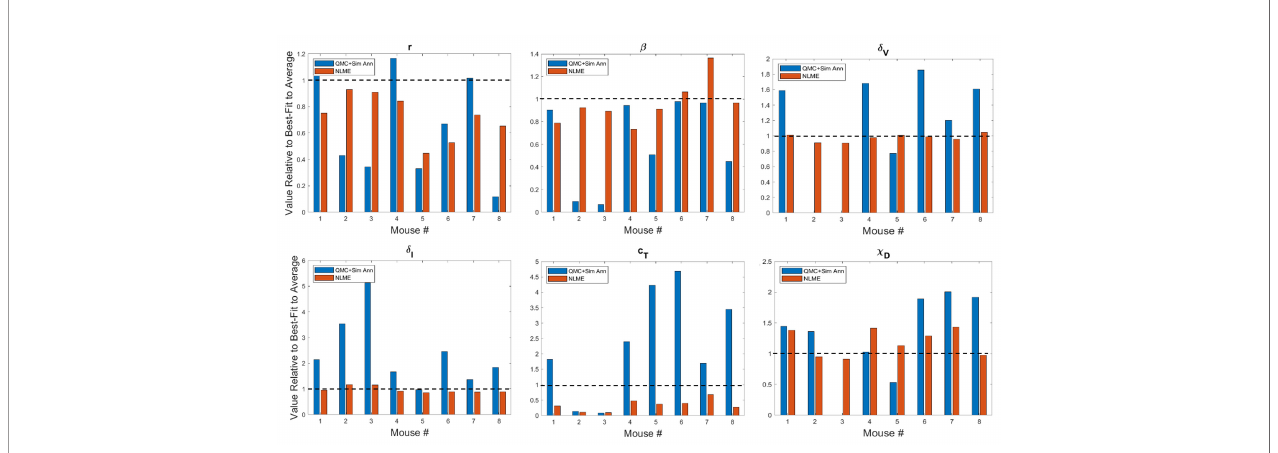
FIGURE 3 | Best- fi t values of tumor growth rate parameter r , virus infectivity parameter b , viral decay rate d v , infected cell lysis rate d I , T cell stimulation term by immunostimulants c T , and T cell stimulation term by DCs c D . The best- fi t values are shown for each mouse and are presented relative to the best- fi t value of the parameter in the average mouse (35). Therefore, a value of 1 (shown in the dashed black line) means the parameter value is equal to that in the average mouse, less than 1 is a smaller value, and greater than 1 is a larger value. Values for other model parameters are shown in Figure S2